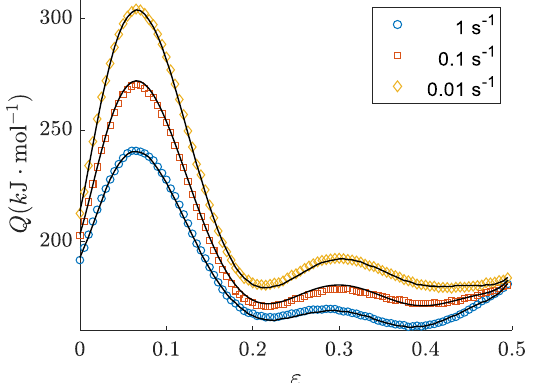
Figure 9. The obtained activation energies (unfilled-symbols) and their estimations (continuous lines) as functions of strain and strain rate using method 1.